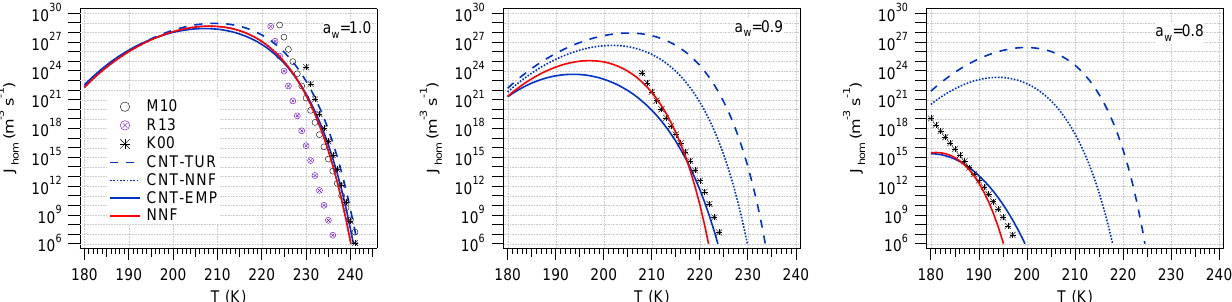
Figure 3. Homogeneous nucleation rate. K00, M10 and R13 refer to results obtained using the correlations of Koop et al. (2000), Murray et al. (2010a) and Riechers et al. (2013), respectively. For CNT σ iw was calculated using the Turnbull (1950) correlation (CNT-TUR, Eq. 25), an empirical correlation derived from fitting CNT to the K00 parameterization (CNT-EMP, Eq. 29), and a theoretical expression derived from the NNF model (CNT-NNF, Eq. 27). Results using the NNF model (Eq. 19) are also shown.